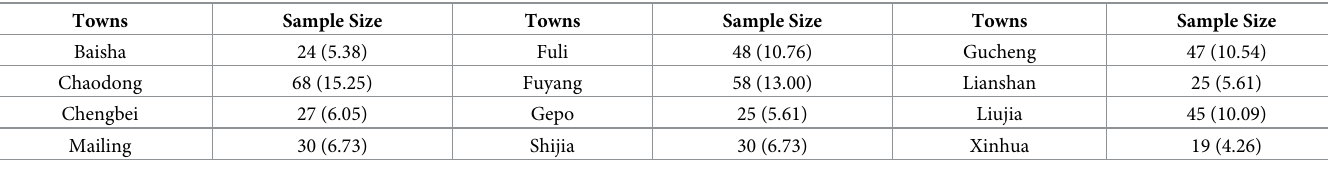
Table 1. Sample towns (number,